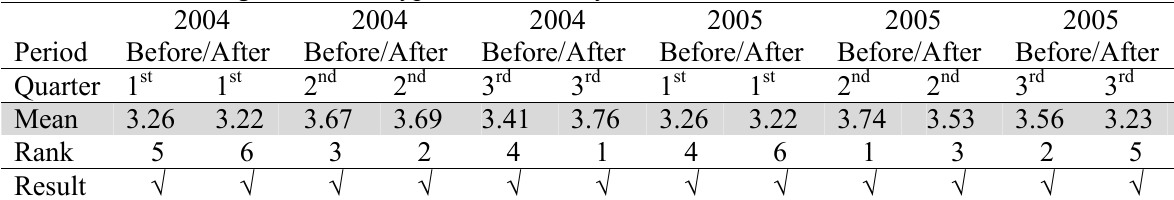
The results of testing the second hypothesis for the years of 2006 2006 2006 2006 Period Before/After Before/After Before/After Quarter Mean